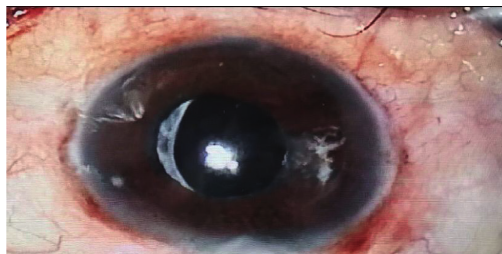
Figure 2: Appearance of the eye after contact transscleral diode laser cyclophotocoagulation.